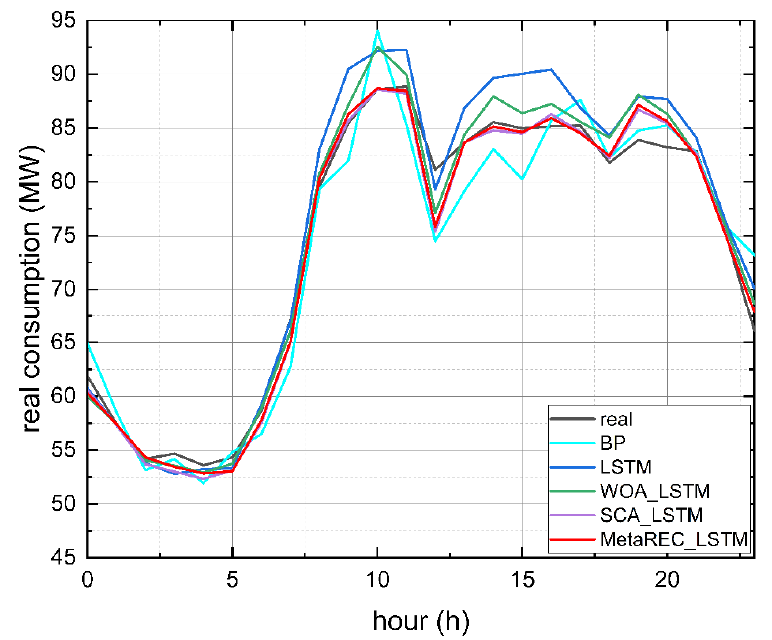
Figure 14. Electric load measurements and predictions made by various methods.